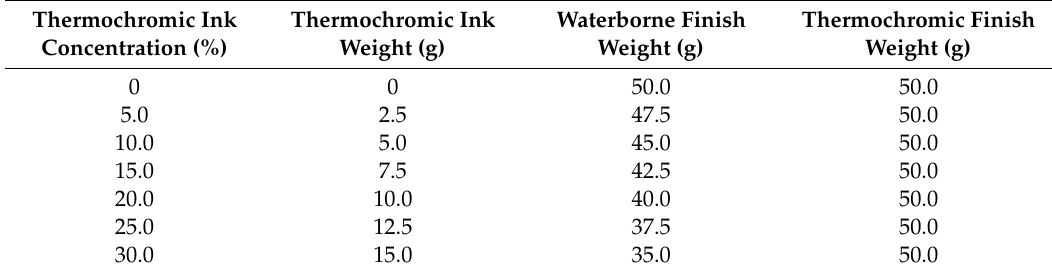
Table 1. The composition of finish coating with thermochromic